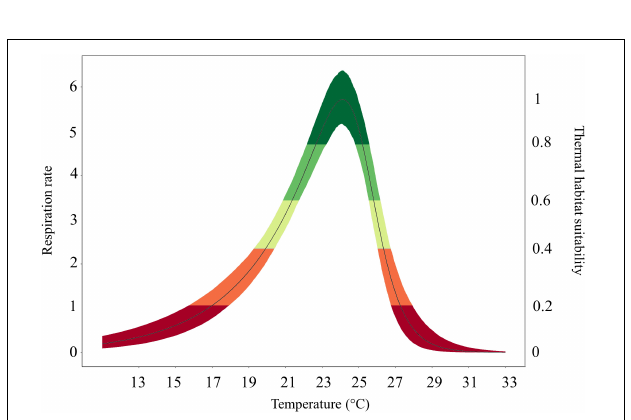
FIGURE 2 | Morphological features of experimental colonies at different tested temperatures: (A) healthy and performant polyp at 23 ◦ C and (B) damage hydrants at 29 ◦ C. Scale bar = 500 µ m.